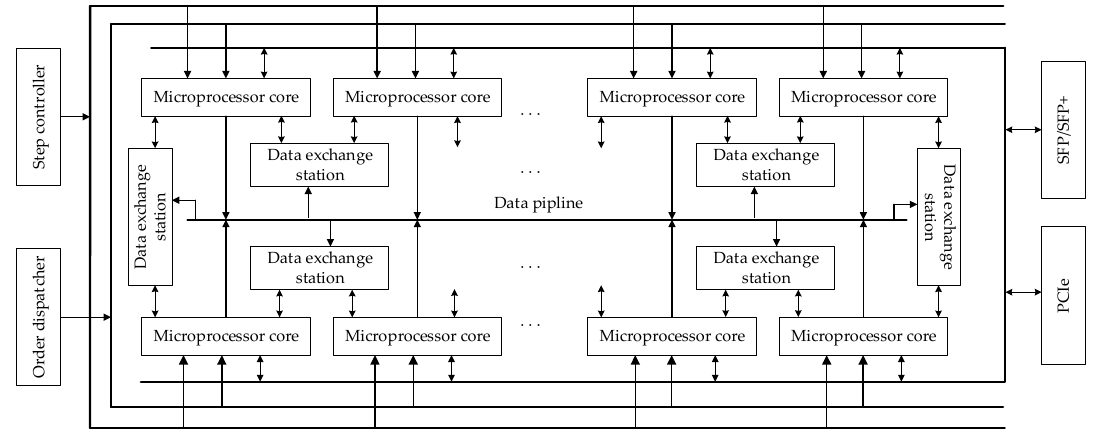
Figure 1. The overall structure of the real-time solver.